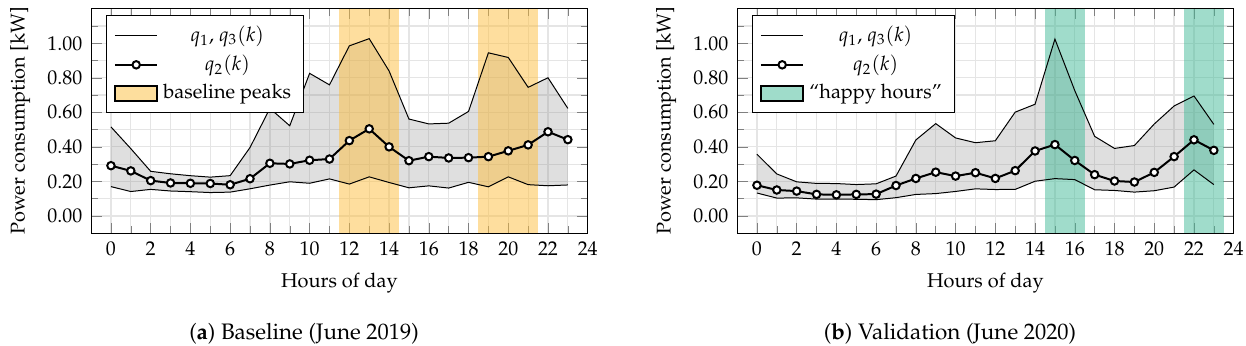
Figure 8. Comparison between the distributions of hourly energy consumptions.